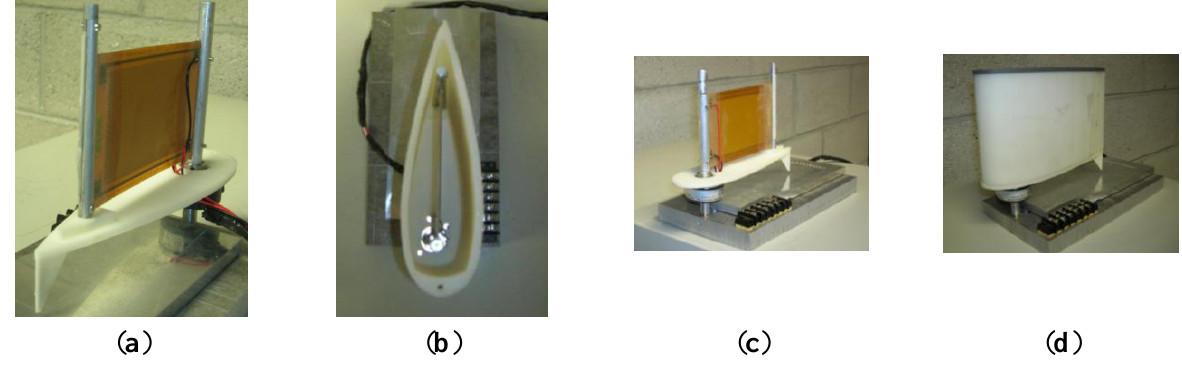
Figure 2. PZT bimorph-actuated smart fin prototype. ( a ) Rear view (without the shell); ( b ) top view; ( c ) side view (without the shell); ( d ) assembled fin